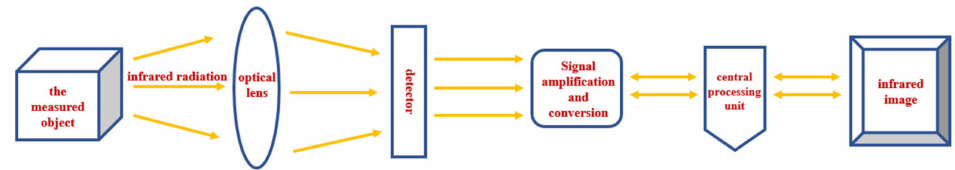
Figure 2. Principal infrared thermal imaging instrument temperature measurement